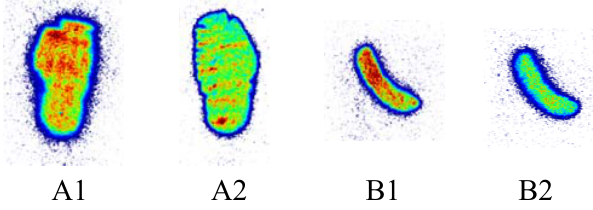
= 2.1 min) after 2 h in PBS and after R